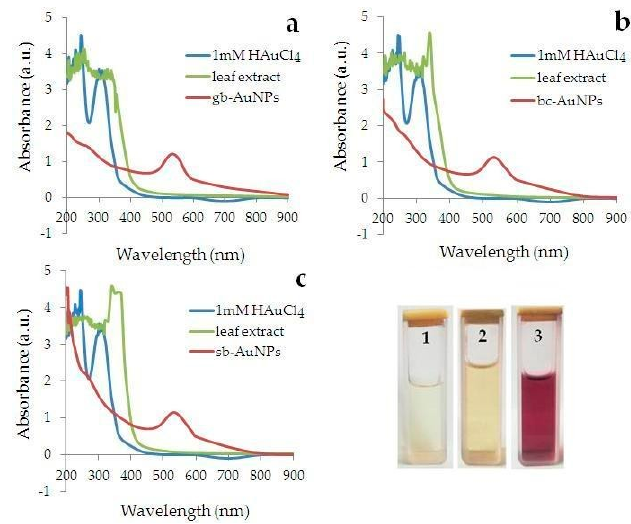
Figure 4. UV-Vis spectra of a 1 mM HAuCl 4 solution, leaf extracts from gooseberry ( a ), blackcurrant ( b ), strawberry ( c ) and phyto-AuNPs suspensions synthesized for 300 s in a reaction mixture containing 5 mL of 1 mM HAuCl 4 and 1 mL of leaf extract. Photographs: a solution containing 1 mM HAuCl 4 ( 1 ), strawberry extract ( 2 ) and sb-AuNPs suspension ( 3 ).